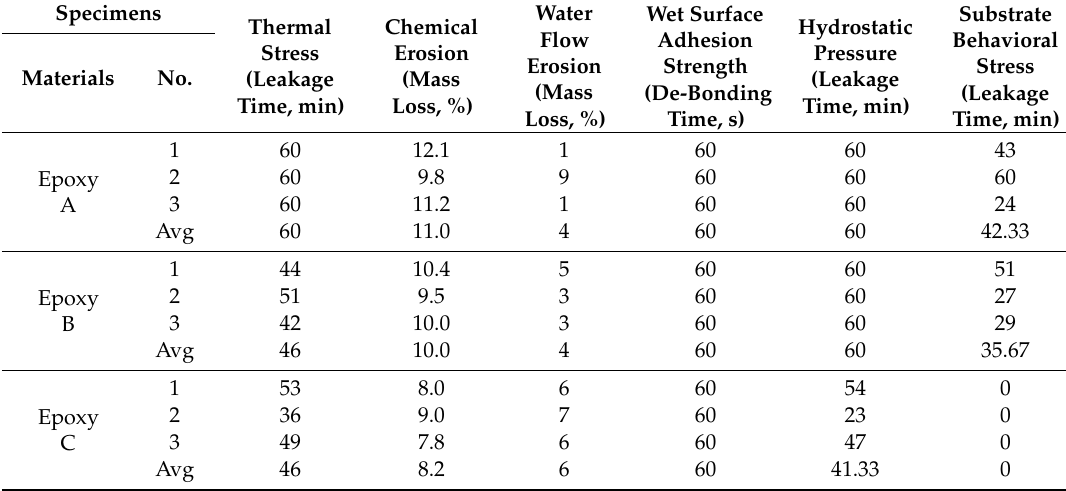
Table 7. The evaluation results of the epoxy-resin grout-injection materials. Specimens